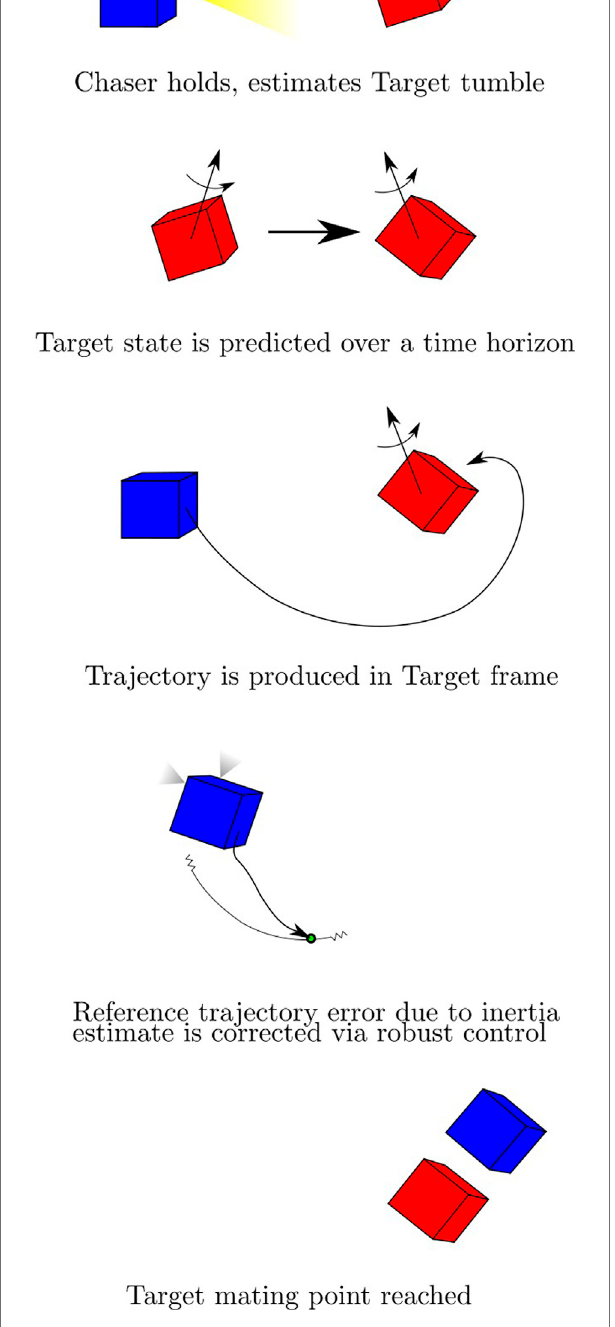
FIGURE 3 | The concept of operations for the autonomous docking procedure withChaser(blue)and Target(red). Followingastandoffestimation phase a motion planner uses an estimate of future Target attitude to create a plan in the inertial frame, which is tracked by a robust controller. Uncertainty is converted from Target parameter uncertainty to Chaser reference trajectory uncertainty